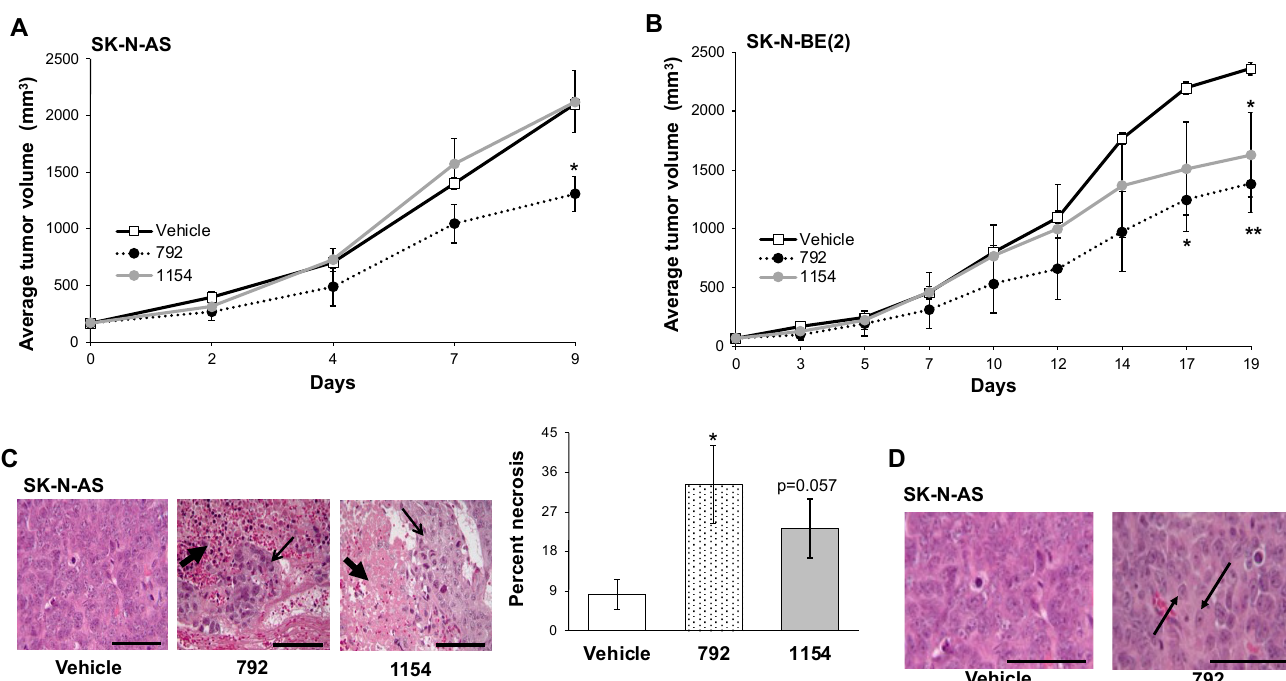
Figure 6. In vivo evaluation of 792 and 1154. SK-N-AS (1.8 × 10 6 ) or SK-N-BE(2) (1.5 × 10 6 ) cells were injected into the flanks of female athymic nude mice. Treatment with vehicle, 792, or 1154 (50 mg/kg, bid, po) began once tumors reached a volume of 100 mm 3 ( n = 5 for SK-N-AS vehicle treated, n = 7 for SK-N-AS 792 or 1154 treatment and all SK-N-BE(2) experimental groups). Tumor volumes were measured 3 times per week, and animals were weighed weekly. ( A ) Animals bearing SK-N-AS tumors treated with 792 had significantly decreased tumor volumes compared to those in animals treated with vehicle or 1154. Animals treated with 1154 did not show significant decrease in tumor volume compared to vehicle-treated animals. ( B ) In SK-N-BE(2) tumor-bearing animals, treatment with 792 and 1154 resulted in significantly decreased tumor volumes compared to vehicle. There was no significant difference in tumor growth in animals treated with 792 compared to those treated with 1154. ( C ) H&E staining revealed necrosis in 792- and 1154-treated tumors ( closed black arrows ). Areas of viable tumor are marked with open black arrows. Percent necrosis of the SK-N-AS tumors was quantified by a pathologist blinded to the treatment groups. Percent necrosis in SK-N-AS tumors from animals treated with 792 was significantly increased compared to tumors from animals treated with vehicle (33.3 ± 8.8% vs. 8.3 ± 3.3%, 792 vs. vehicle, respectively, p ≤ 0.05). Tumors from animals treated with 1154 also demonstrated increased necrosis but when quantified, did not reach statistical significance (23.3 ± 6.7% vs. 8.3 ± 3.3%, 1154 vs. vehicle, respectively, p = 0.057). ( D ) H&E staining of SK-N-AS tumors treated with 792 showed the presence of ganglion cells ( black arrows ), which were not seen in tumors from animals treated with vehicle. Presence of ganglion cells in neuroblastoma reflects tumor cell differentiation. Data reported as mean ± SEM. Scale bars represent 0.1 mm. Student’s t-test was use for comparison. * p ≤ 0.05, ** p ≤ 0.01, compared to vehicle.